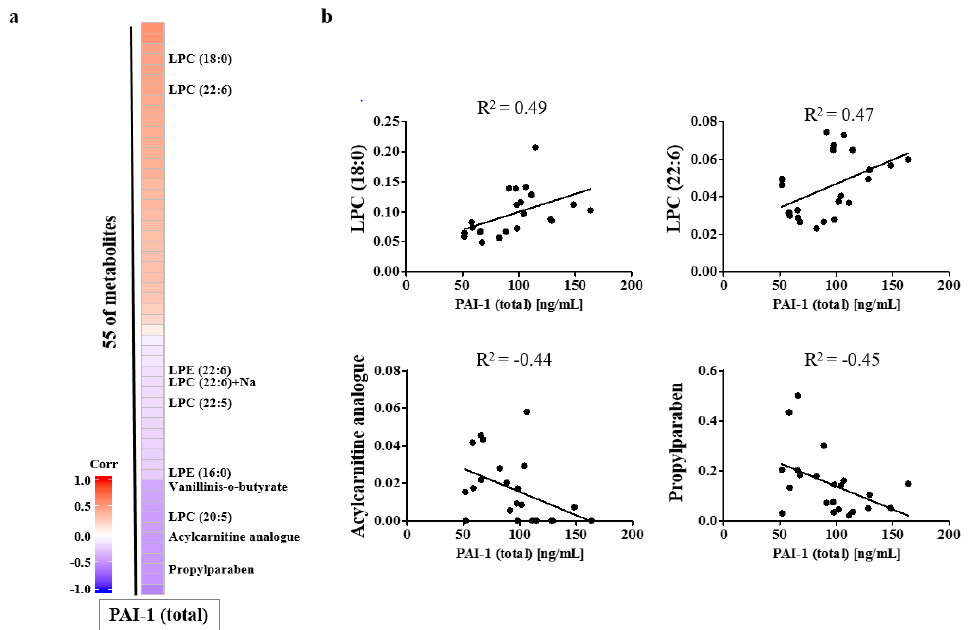
Figure 4. Heatmap for the identified serum metabolites ( a ) and correlation between the serum PAI-1 concentration and each metabolite ( b ). LPC, lysophosphatidylcholine; PAI-1, plasminogen activator inhibitor-1.